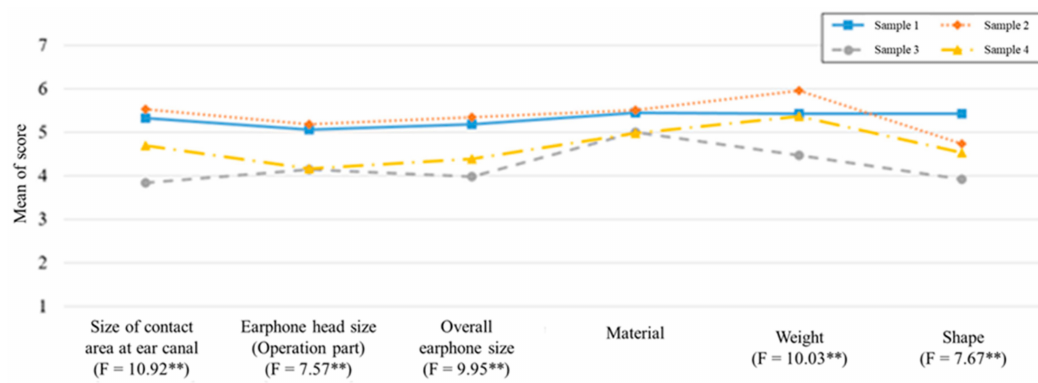
Figure 5. Results of ANOVA for appropriateness of product designs (**: p < 0.01).